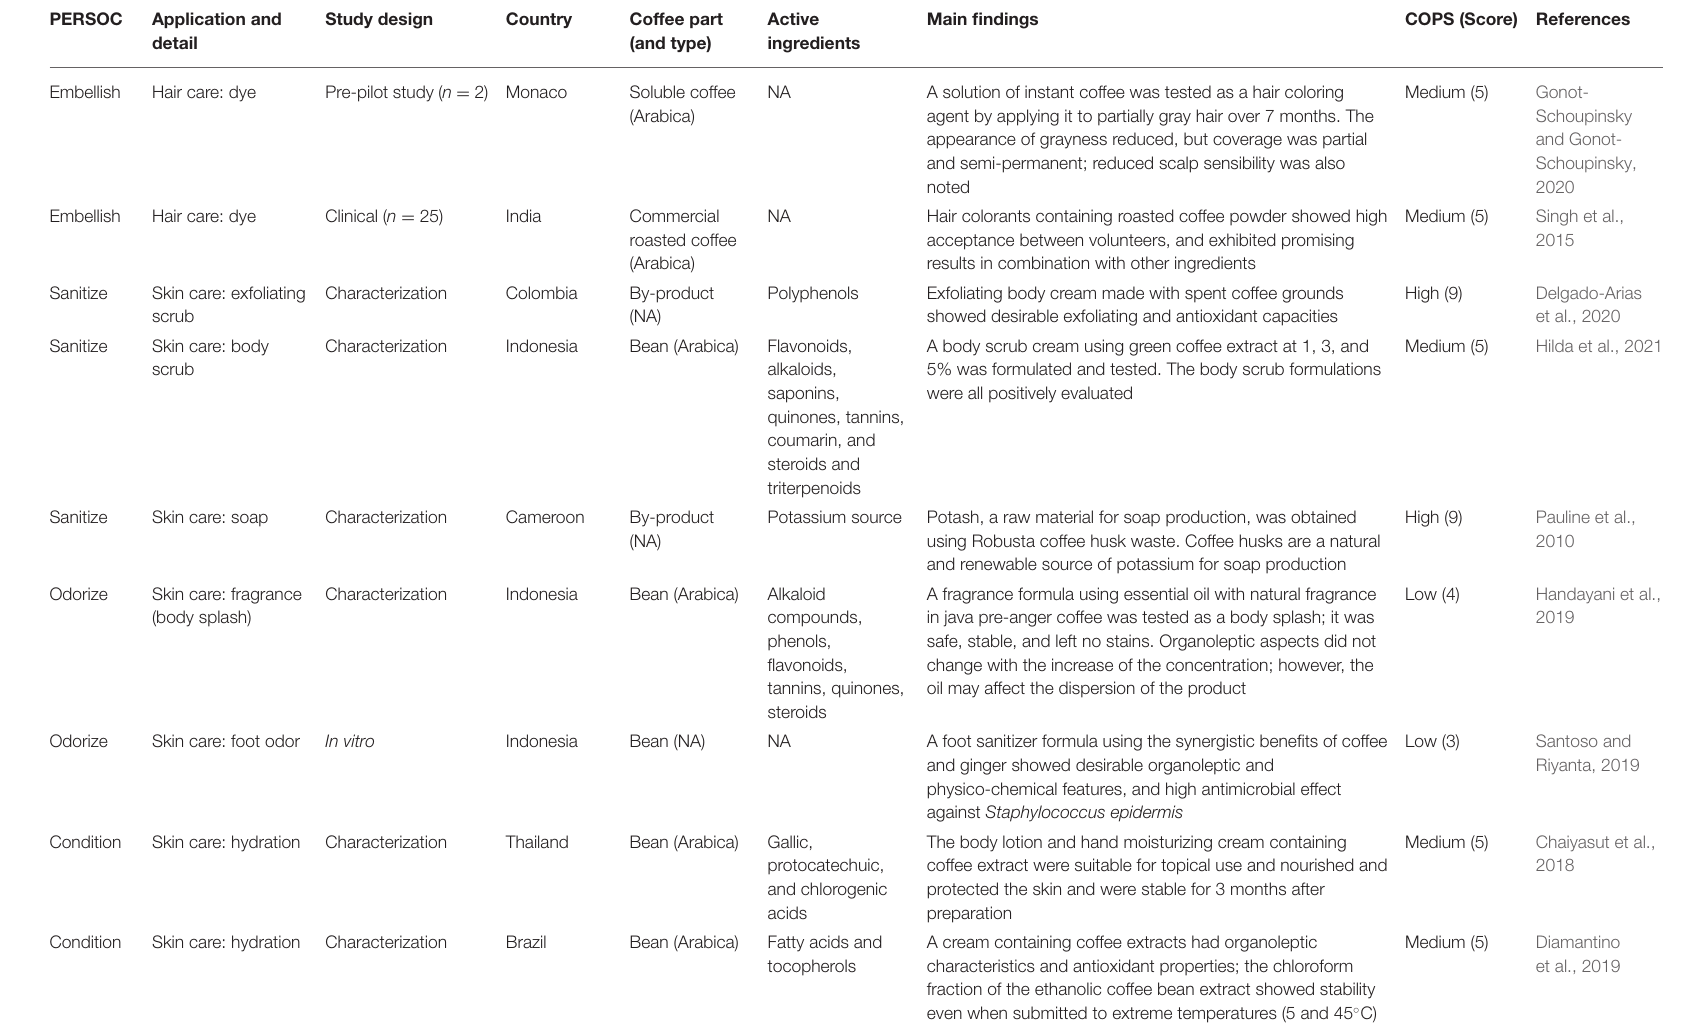
TABLE 5 | Data extraction and COPS classification of the 13 papers classified according to PERSOC where “embellish,” “sanitize,” “odorize,” or “condition” are perceived as the dominant aim.